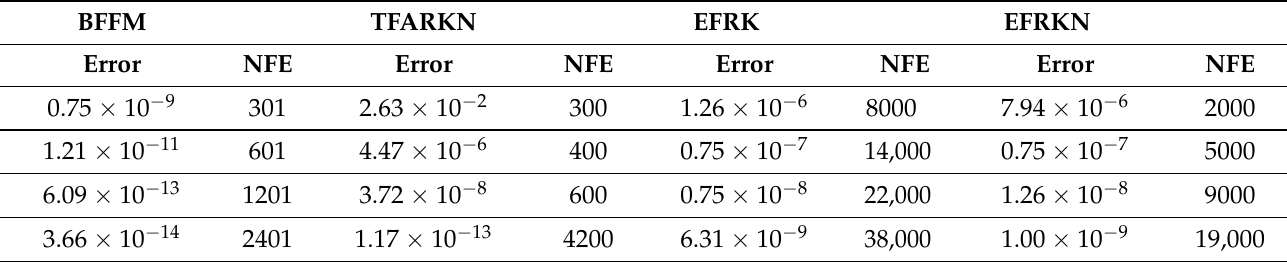
Table 4. Data for Example 4 with ω = 1 and (cid:101) = 10 − 10